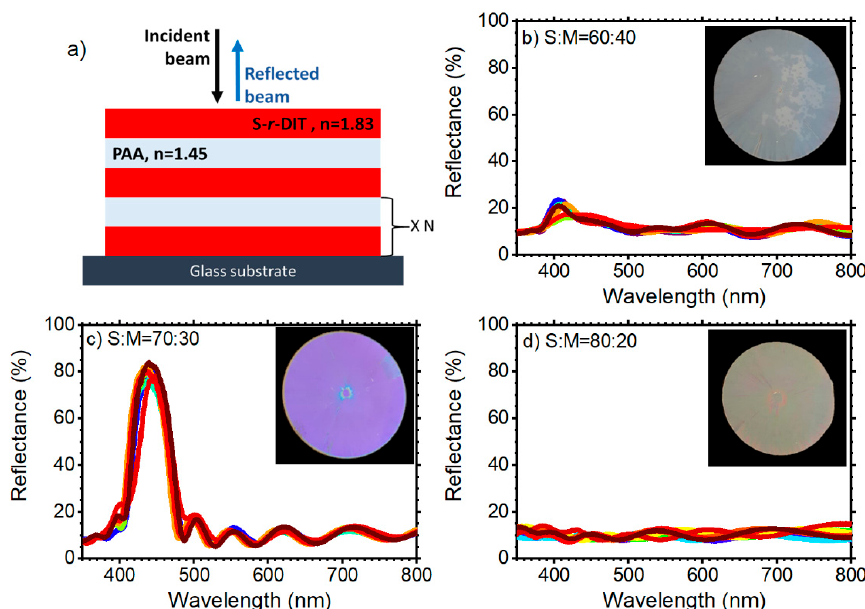
Figure 2. ( a ) Schematic and ( b – d ) reflectance spectra and surface photographs of three inverse vulcanized polymer: poly( N -vinyl carbazole)–polyacrylic acid (IVP:PVK–PAA) distributed Bragg reflectors (DBRs) made of 10.5 bilayers where the IVPs were synthesized from reactant mixtures that contained 60 wt% ( b ), 70 wt% ( c ) and 80 wt% ( d ) of sulfur with respect to 2,5-diisopropenilthiophene.